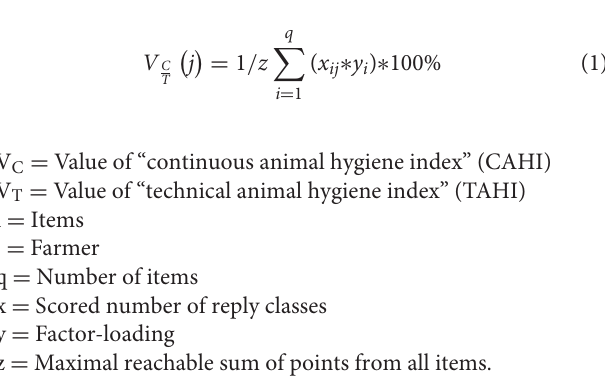
Animal Hygiene Index